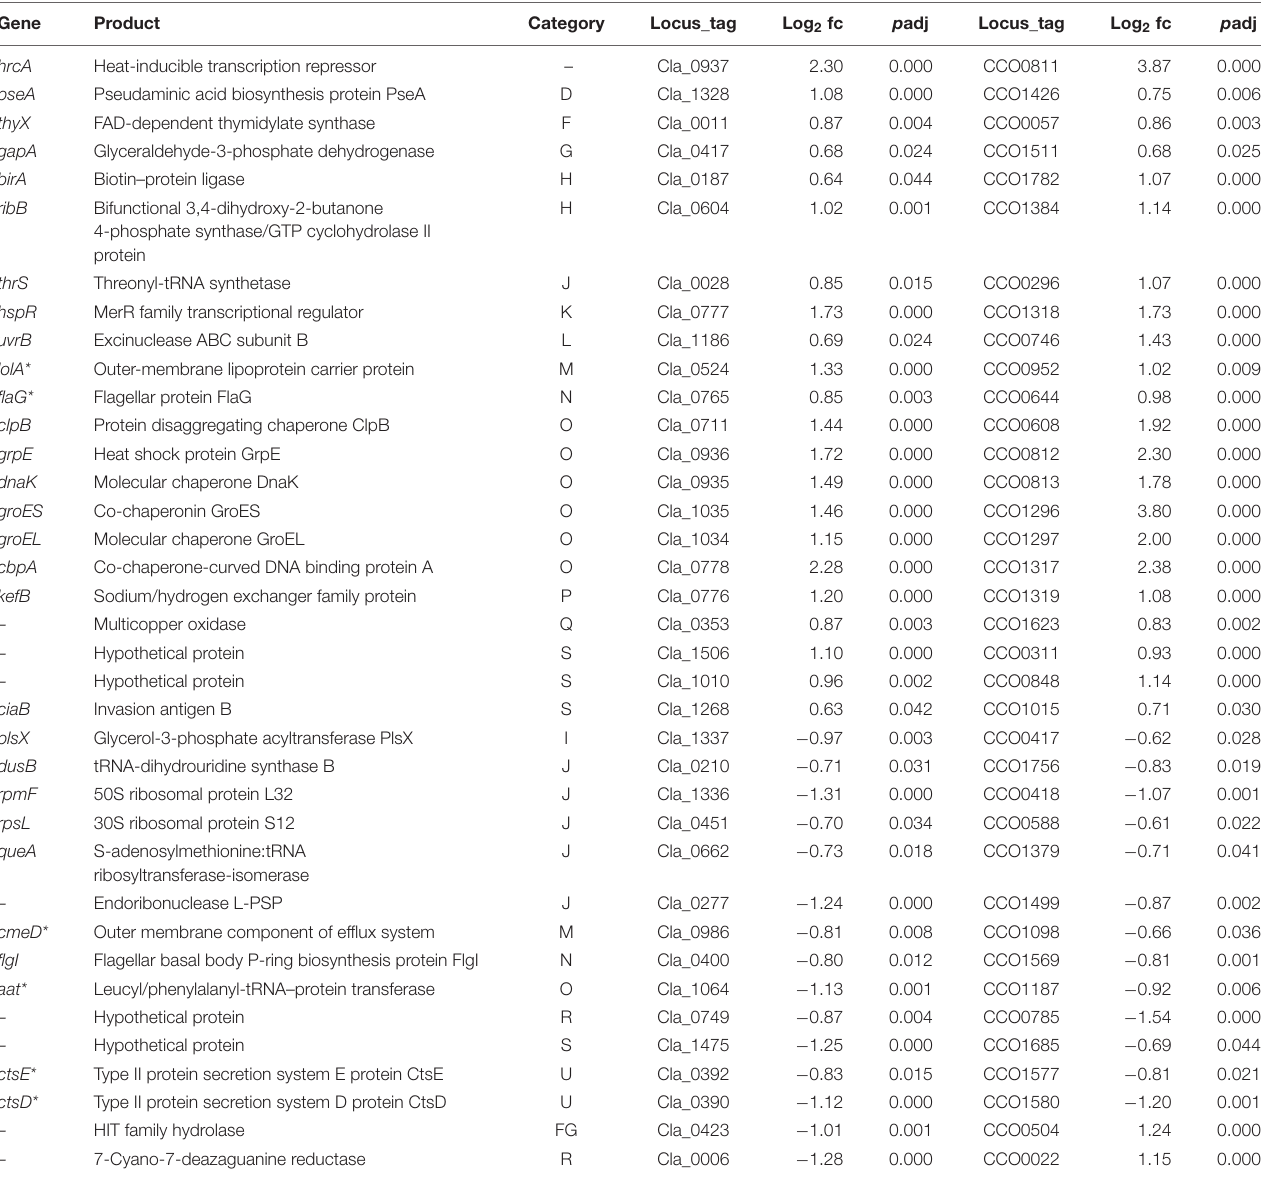
TABLE 2 | Similar regulated genes after heat stress in C. coli RM2228 and C. lari